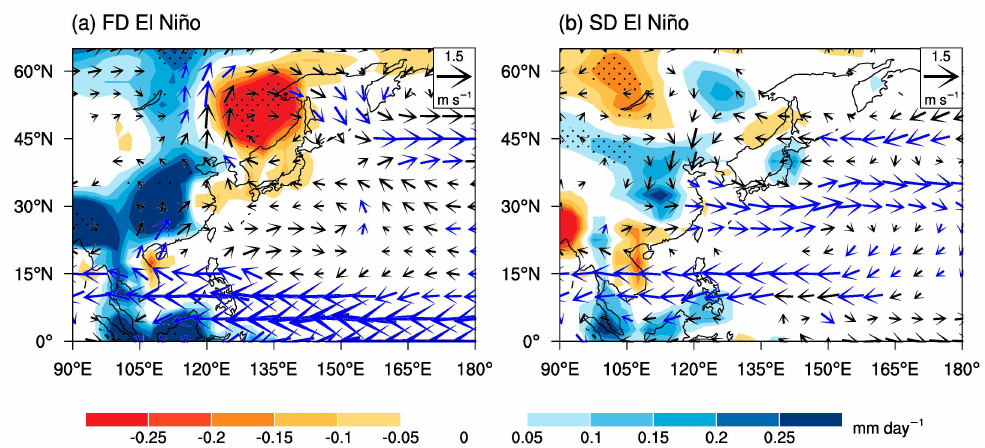
Figure 8. Same as Figure 2 but for the rainfall anomalies (shaded), 850 hPa wind anomalies (vectors) in ( a ) FD El Niño summers and ( b ) SD El Niño